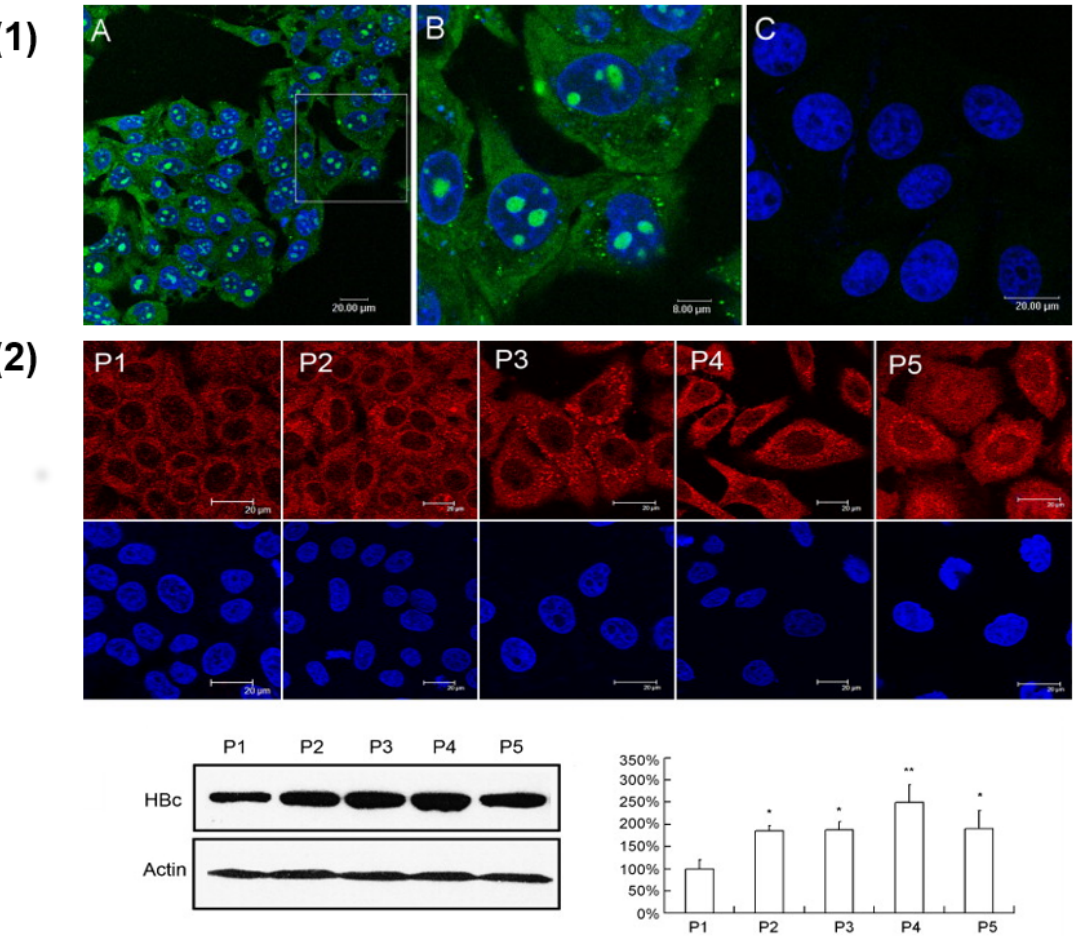
Figure 4. ( 1 ) Evaluation of cell-penetrating activity of the peptides in the HepG2.2.15 cells by confocal microscope detection. ( A ) HepG2.2.15 cells were treated with 10 µ M of FITC-R7-GSLLGRMKGA peptide for 30 min. Nuclei were stained with DAPI (blue); ( B ) shows an enlargement of the white-frame area in ( A ); in ( C ), the HepG2.2.15 cells were treated by 10 µ M of FITC-GSLLGRMKGA control peptide without R7. ( 2 ) Analysis of HBV core protein in HepG2.2.15 cells treated with peptides. Cells were treated with 10 µ M of peptides for three days and stained by immunofluorescent staining (upper). Cells were scanned by confocal microscope for subcellular distribution of core protein (red). The core protein was also quantified by Western blot analysis (lower). Optical densities of the core protein were analyzed using QuantityOne software. All values are means ± SD of results from three independent experiments. Values significantly different from control peptide group are indicated by a Student’s t -test. * p < 0.05; ** p < 0.01 (reproduced with permission from